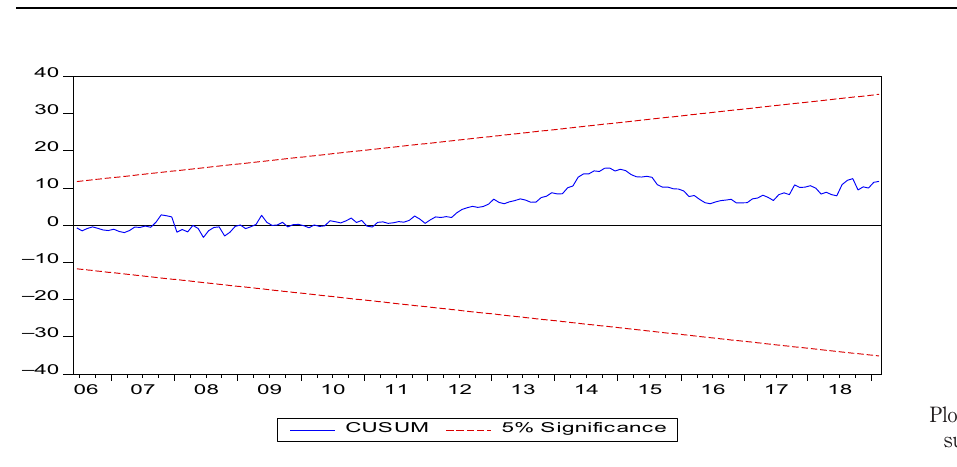
Figure 1. Plot of